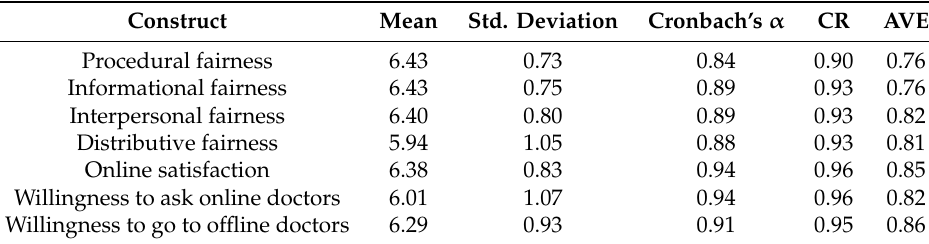
Table 1. Results of the reliability test.